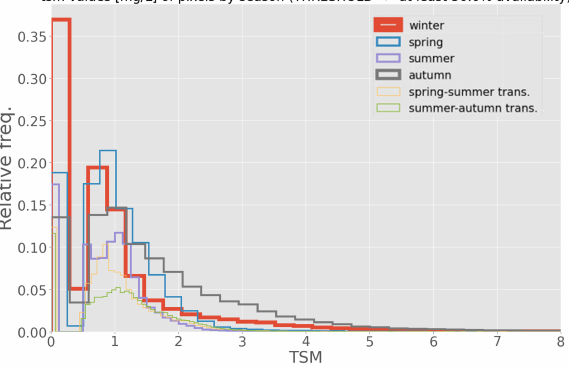
Figure 3. Data availability - LSWT, full period.